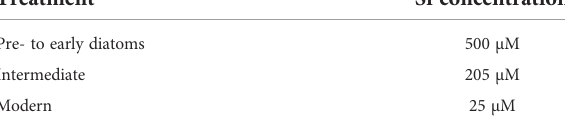
TABLE 2 Silicic acid concentrations added to the Mesozoic/ Cenozoic medium to mimic the progressive DSi depletion through geologic